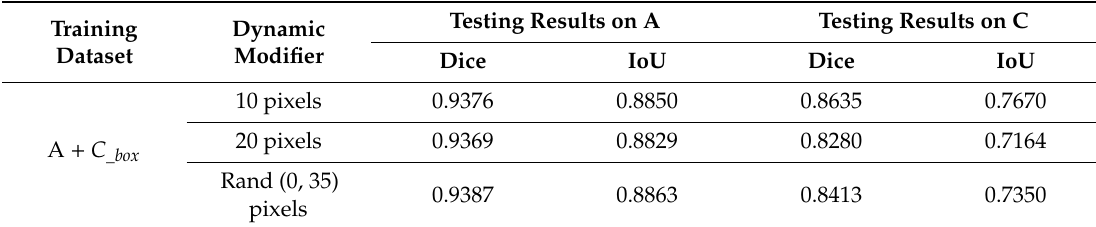
Table 6. Quantitative results for stage-wise training (ResNet50) using dynamic bounding box sizes.